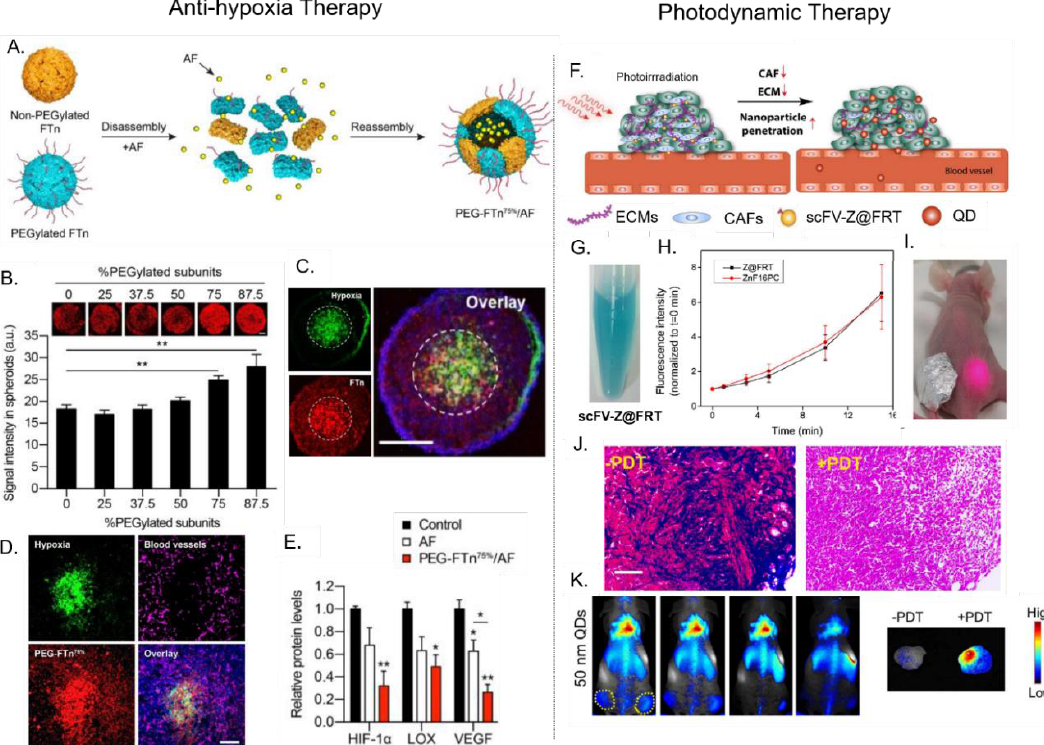
Figure 3. Examples of PNP-mediated drug delivery for different cancer therapies. ( Left panel ) Anti-hypoxia therapy: ferritin-mediated delivery of the HIF-1 α inhibitor, Acriflavine (AF). ( A ) AF is encapsulated within PEGylated ferritin (FTn) via assembly-disassembly method. ( B ) Fluorescence microscopy showed that the PEGylation density of FTn affected its ability to penetrate 3D lung cancer tumor spheroids. ( C ) FTn with a PEG coverage of ≥ 75% (PEG–FTn 75% ) showed deep penetration and accumulation within inner hypoxic areas of tumor spheroids. ( D ) Tumor sections from orthotropic lung tumor-bearing mice showed that PEG–FTn 75% successfully penetrated inner hypoxic areas in tumors after systemic injection. ( E ) Delivery of AF using PEG–FTn 75% significantly reduce HIF 5 -1 α , LOX, and VEGF expression in vivo. Adapted from [27], with permission from American Chemical Society, 2019. ( Right Panel ) Photodynamic therapy (PDT): ferritin-mediated delivery of photosensitizers for photodynamic therapy. ( F ) Ferritin is used to target the delivery of photosensitizers into tumors to mediate PDT which kills cancer-associated fibroblasts (CAFs), weakens the extracellular matrix (ECM), and enhances the penetration of nanoparticles into the tumor. ( G ) ZnF16PC-loaded chain variable fragment (scFv)–ferritin for targeted PDT ( H ) Both the free photosensitizer ZnF16PC and ZnF16PC-loaded scFv–ferritin produced similar amounts of reactive oxygen species ROS upon irradiation in time dependent manner ( I ) Bilateral tumor bearing mice were used to compare the e ff ect of PDT on the reduction of collagen level in the tumor ECM. The tumor covered with aluminum foil was not irradiated. ( J ) Tumor section from irradiated tumor and non-irradiated tumor. ECM levels were decreased by PDT in the irradiated tumor (Mason’s trichome staining). ( K ) Increased accumulation of 50 nm quantum dots (QDs) in the irradiated tumor after PDT indicated that the decrease in ECM improves the penetration and accumulation of the NDDS in tumor tissue (Maestro II imaging system). Adapted from [31], with permission from American Chemical Society, 2018.